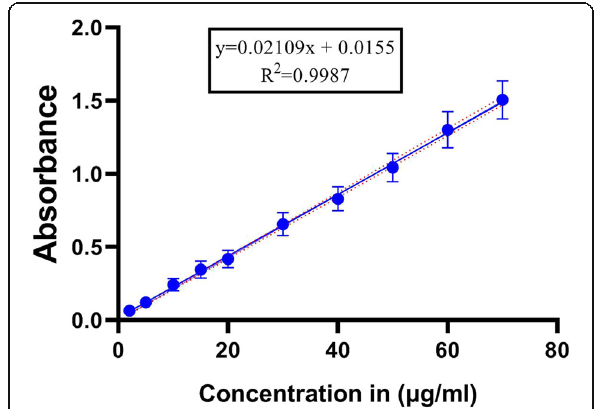
Fig. 7 Calibration curve for camptothecin